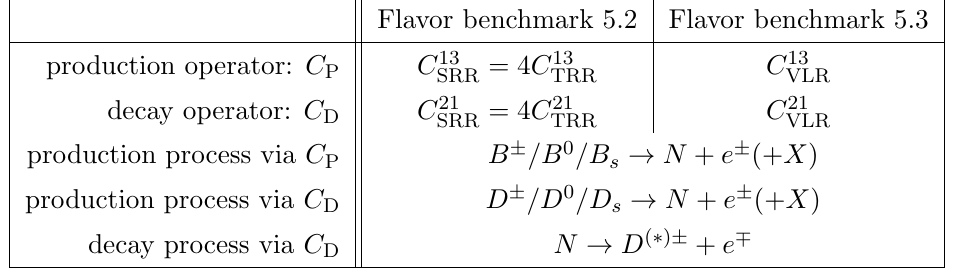
= C vs. m . Compared to the P D N & m . However, for N K